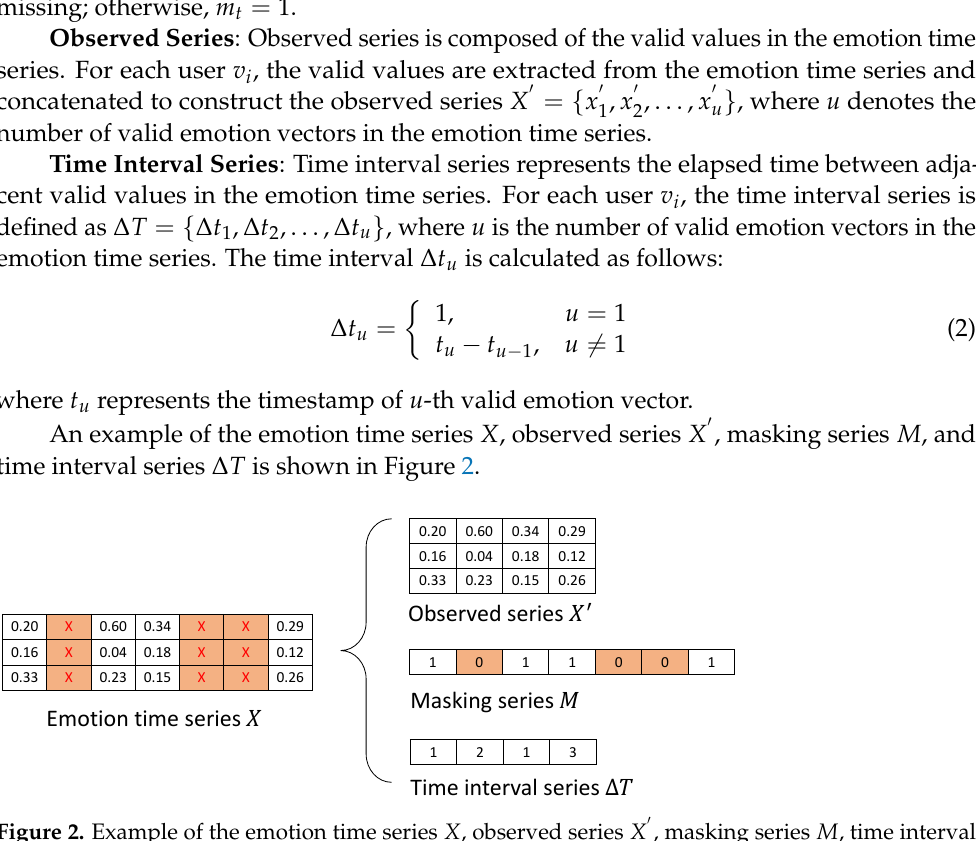
Figure 2. Example of the emotion time series X , observed series X (cid:48) , masking series M , time interval series ∆ T